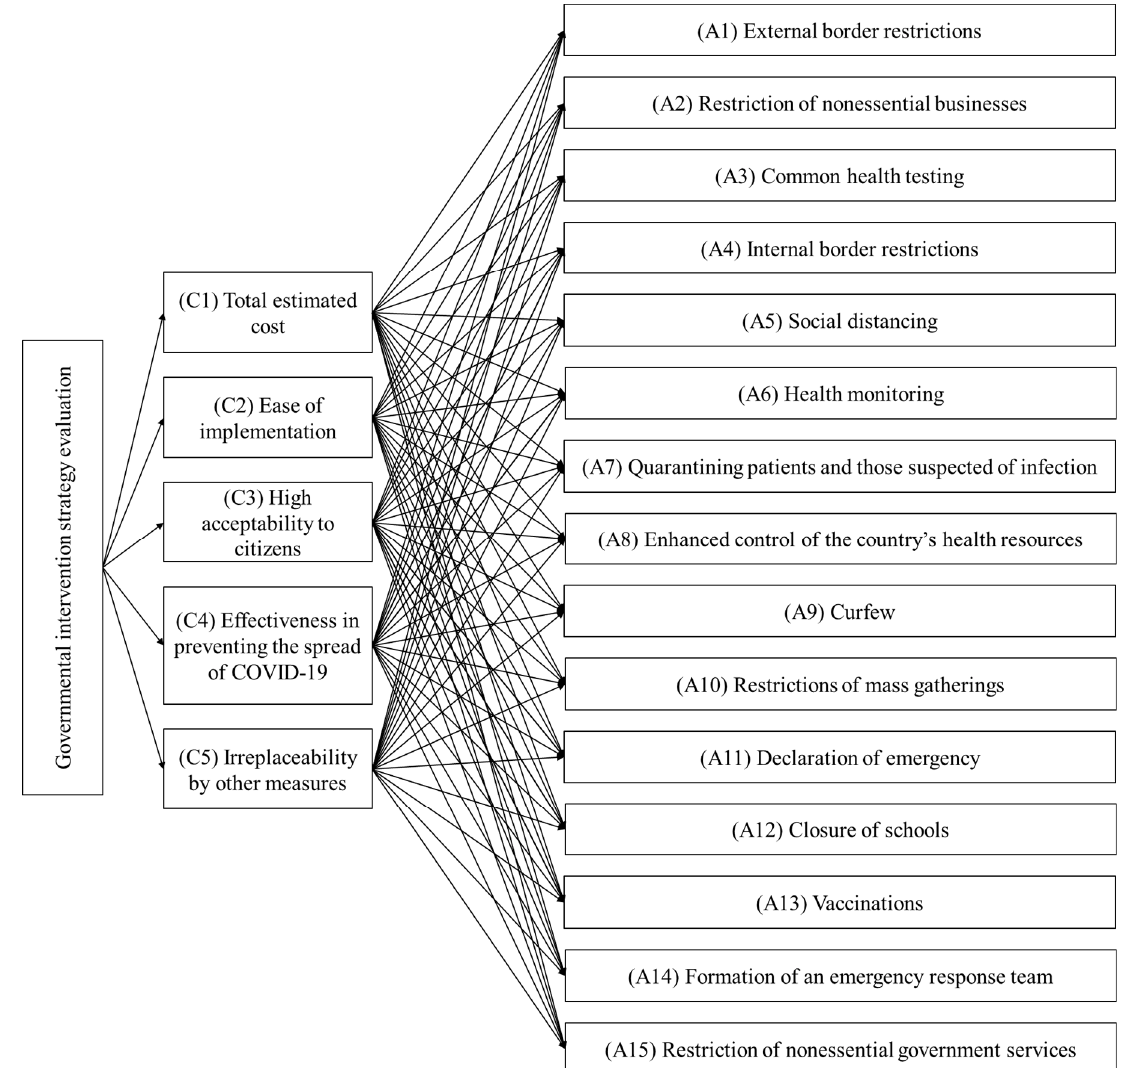
Figure 4. The hierarchical tree of criteria and intervention alternatives for governmental intervention strategy evaluation.